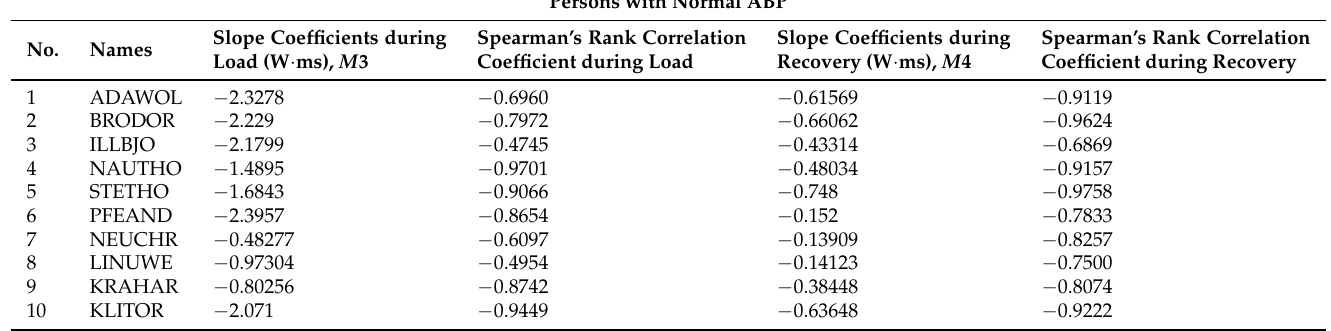
Table 2. Slope coefficients for persons with high ABP during the load and recovery. The goodness of the linear regression fit (for each individual slope coefficient) is measured by the Spearman’s rank correlation